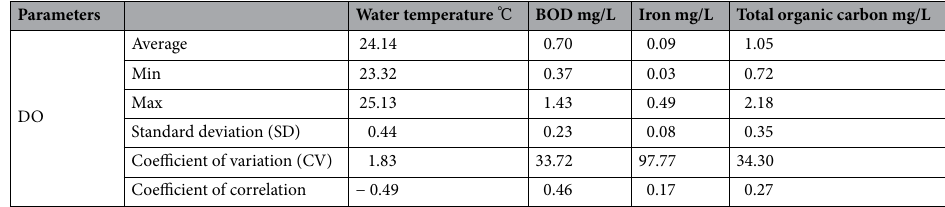
Table 2. Statistical analysis and coefficient of correlation between the input and the output parameters.